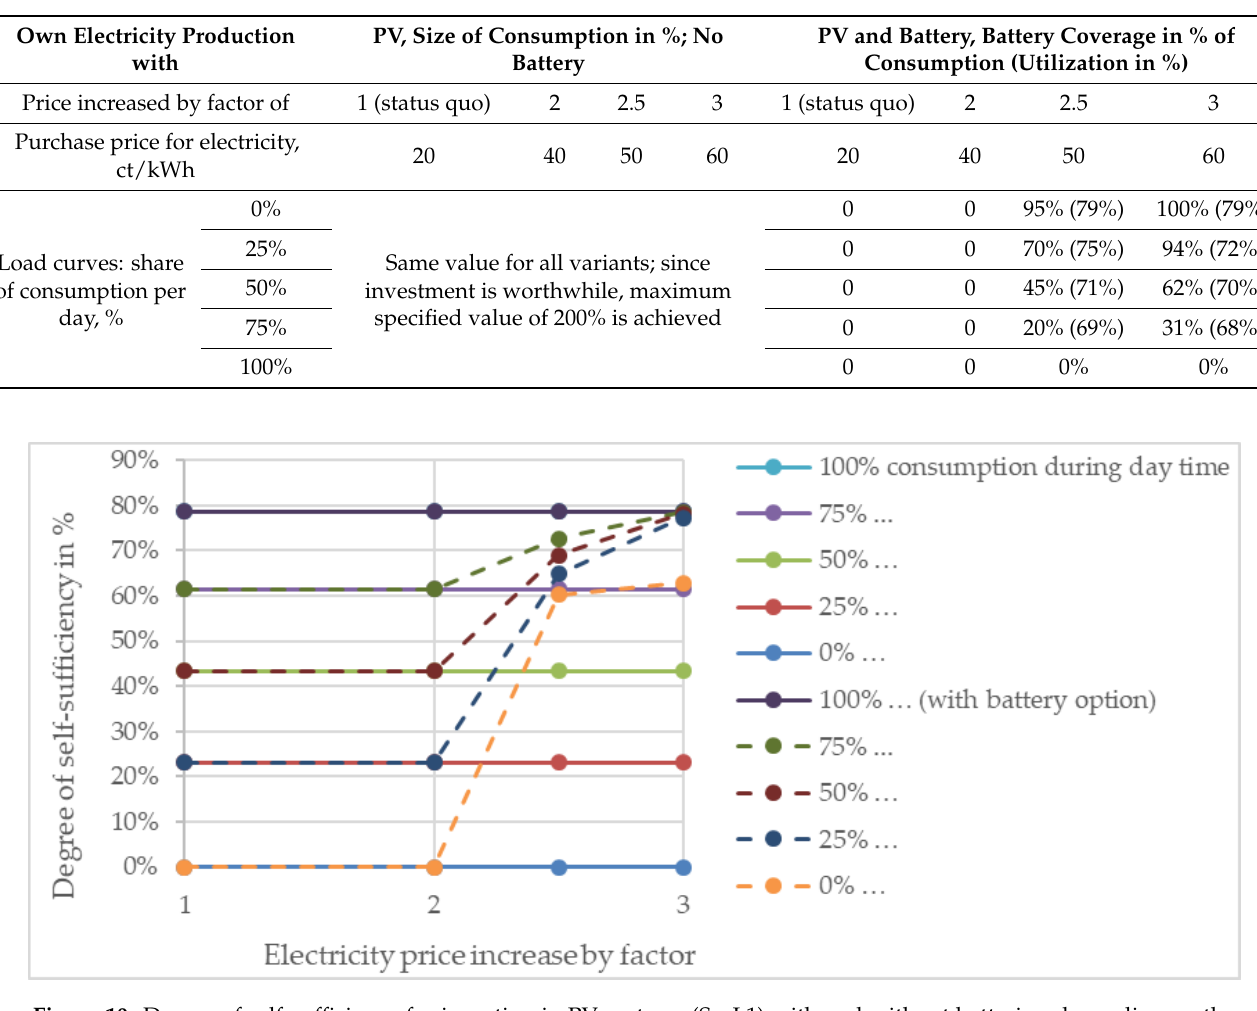
Figure 10. Degree of self-sufficiency for investing in PV systems (Sc_I.1) with and without batteries, depending on the proportion of daytime electricity consumption.